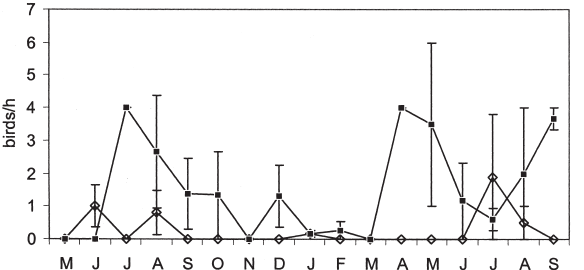
F IG . 4. – Monthly distribution (mean ± SE) of the migratory passage (birds/h) at Pta. das Olas (Caión) in 2000. Open symbols = eastward migration; solid symbols = westward